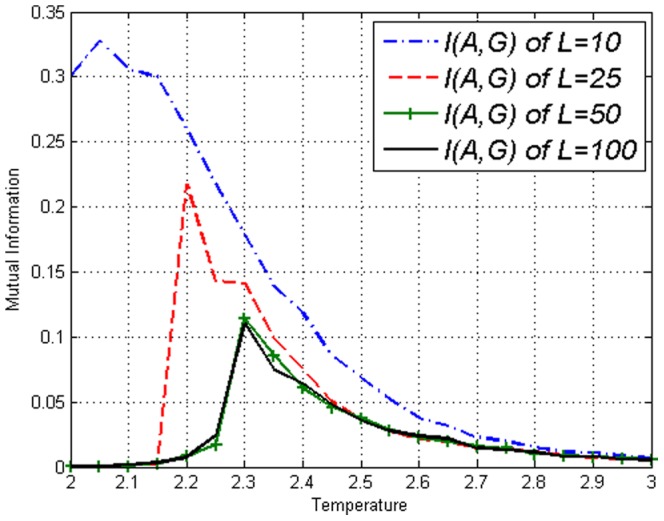
Mutual Information  on the Ising model with lengths L=10,25,50,100 obtained using equation (4).